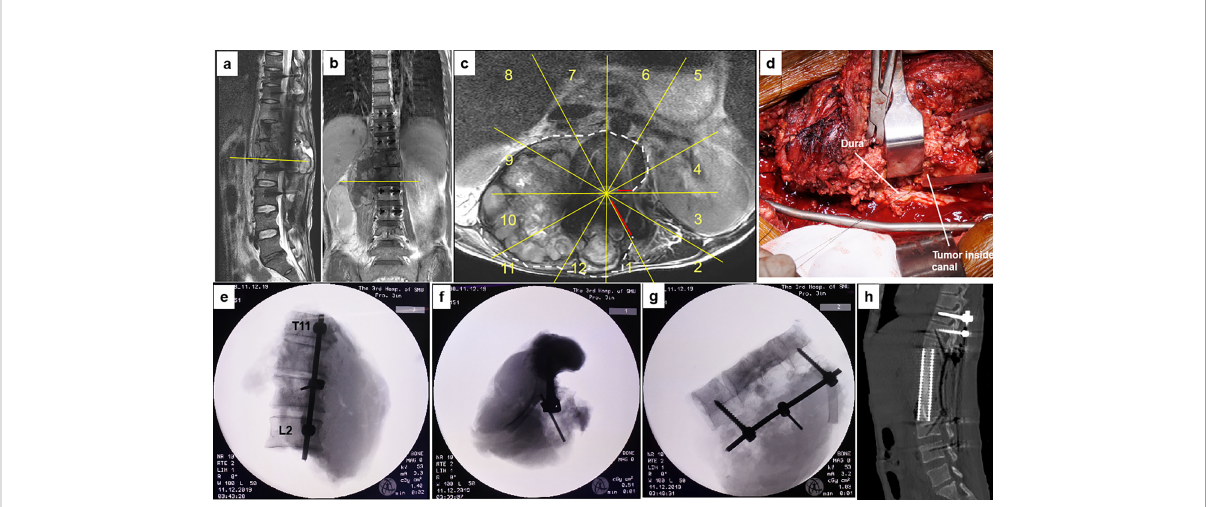
FIGURE 5 A 40-year-old man with osteosarcoma at T11-L2. This patient experienced a local tumor recurrence after two rounds of intralesional excision surgeries combined with radiotherapy in another hospital. MR images (A – C) show tumor recurrence along the right side of T11 to L2 paravertebral with epidural involvement (sectors 4 – 1, D, WBB). Based on the WBB classi fi cation, a four-level (T11-L2) en bloc spondylectomy was performed using the rotation – reversion technique after three courses of chemotherapy. However, due to intracanal tumor contamination caused by the initial operations, the margin along the dura was considered positive (D) . Radiographs of the specimen (E – G) and postoperative CT scans showing structural reconstruction with instrumentation after tumor resection (H) . WBB, Weinstein – Boriani – Biagini.